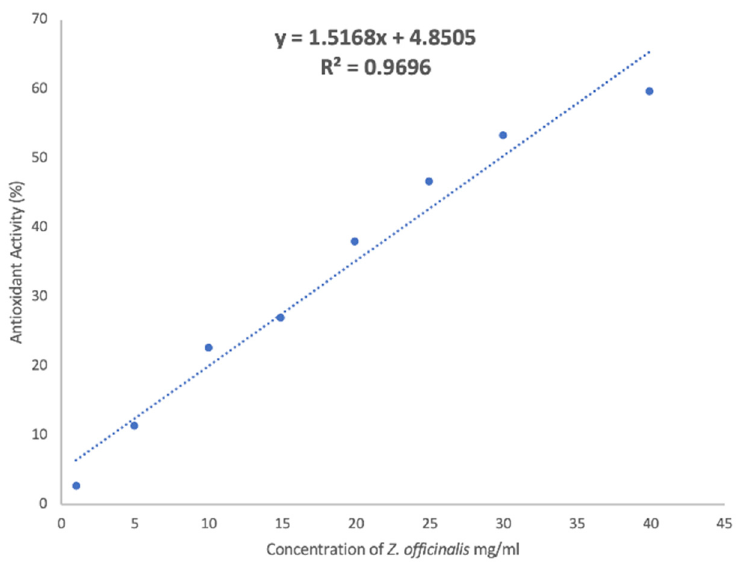
Figure 1. Calibration curve of the antioxidant activity of Z. officinalis extract as a function of its concentration.